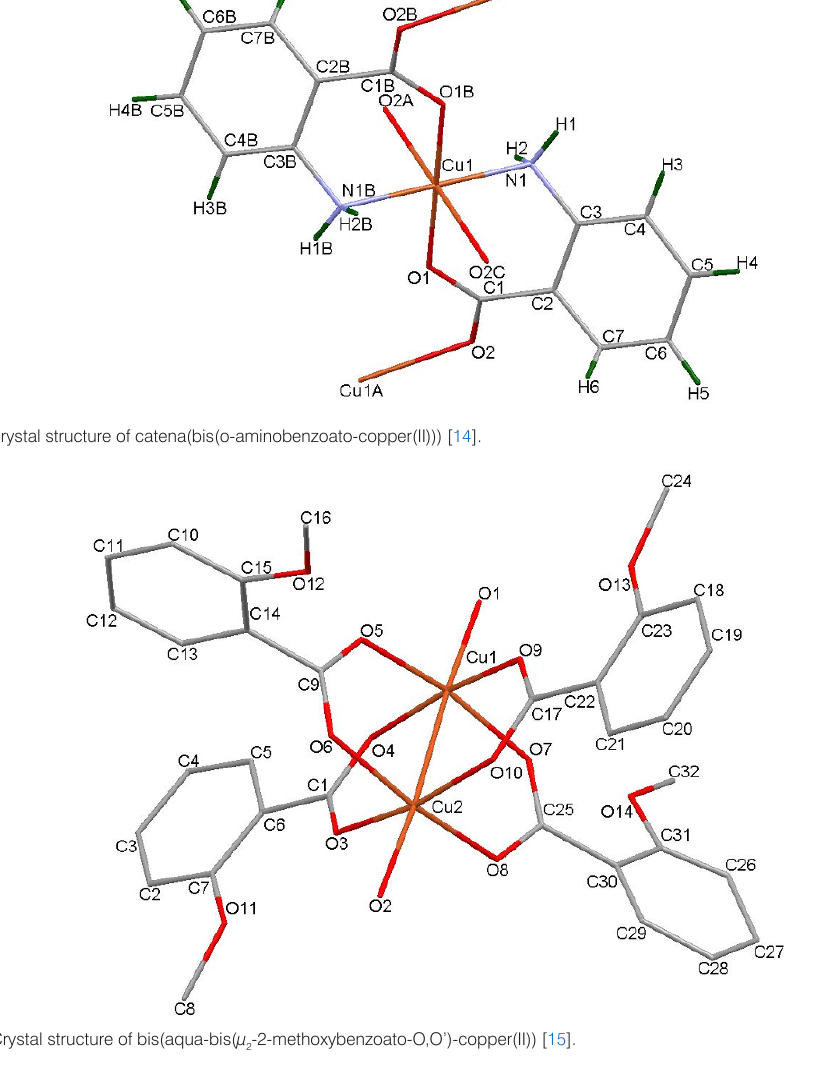
-2-methoxybenzoato-O,O’)-copper(II)) 2